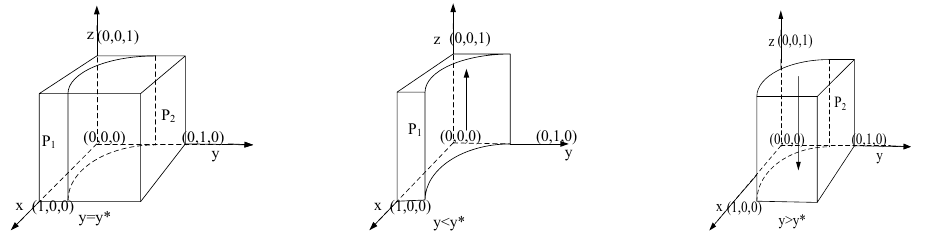
Figure 3. Diagram of the government’s